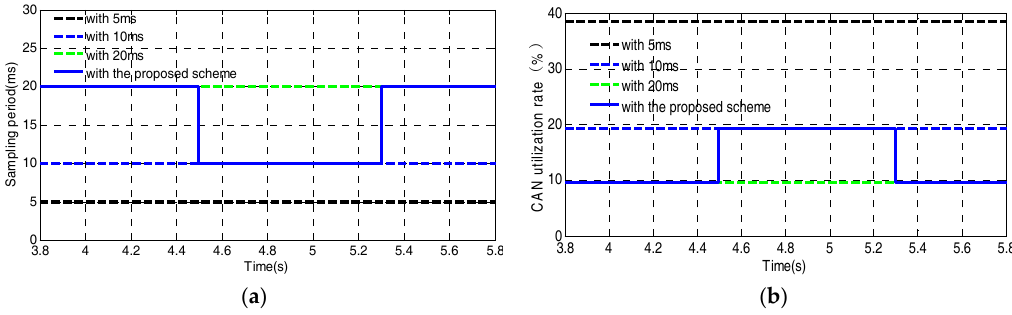
Figure 9. Sampling period and network utilization rate results in simulations. ( a ) Sampling periods